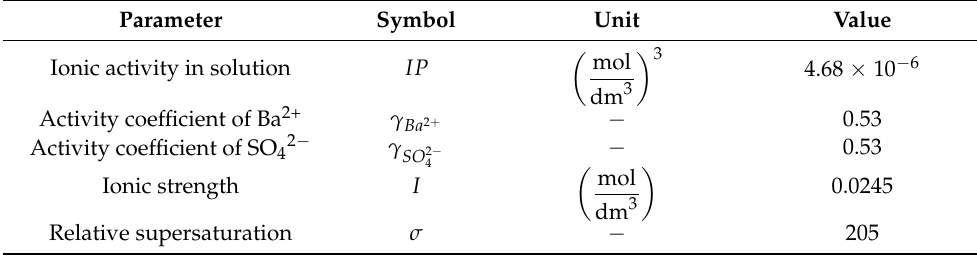
Table 2. Relative supersaturation calculation